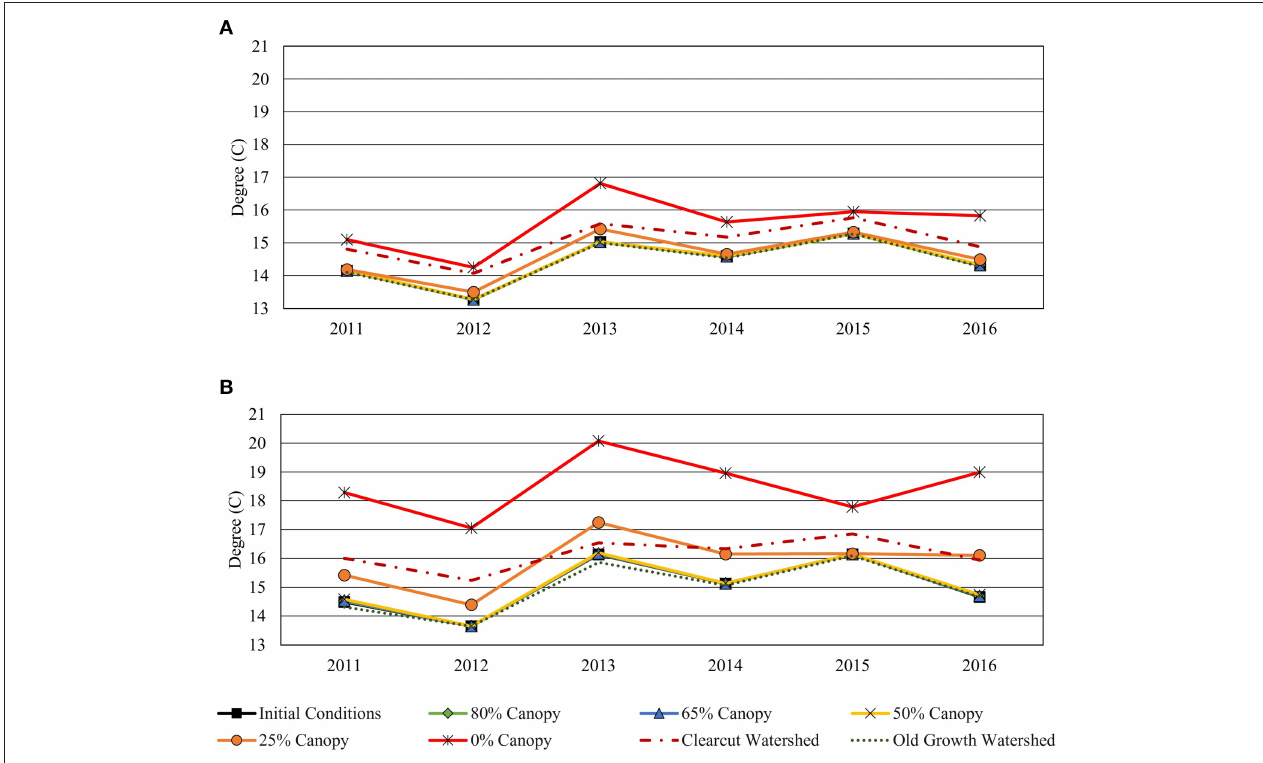
FIGURE 7 | Simulated (A) MWAT and (B) MWMT temperature results for the South Fork mainstem outlet when reducing canopy cover in only Class I watercourses. Solid lines use pre-harvest, second and third-growth vegetation conditions across the watershed, with varying canopy cover in the buffer areas. Dashed lines alter both the watershed and buffer area